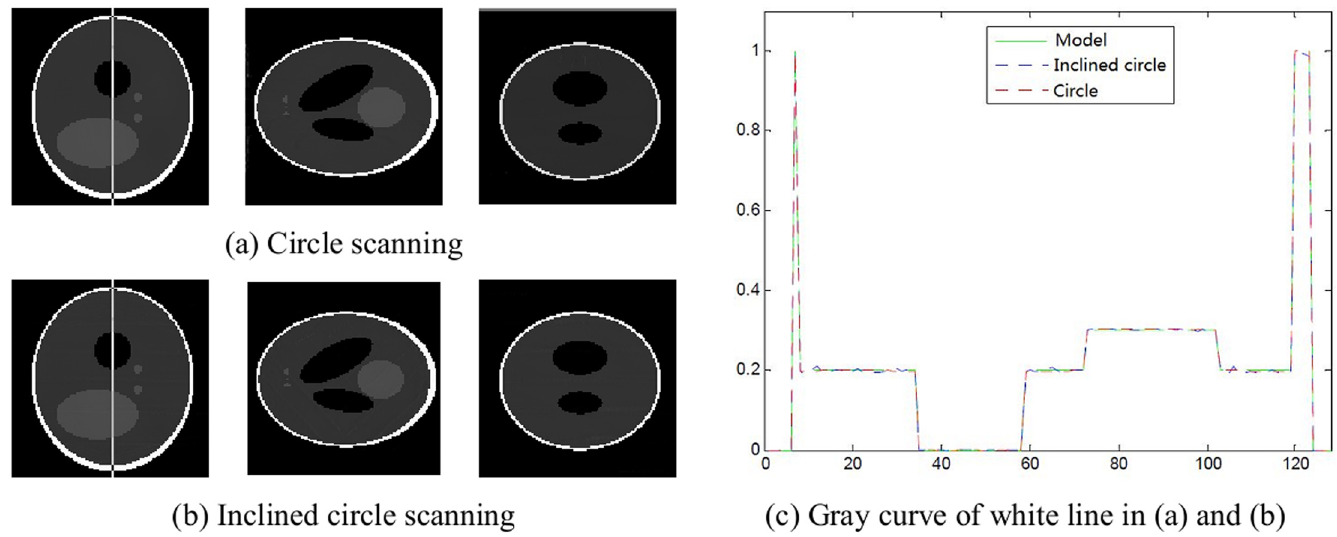
Fig 4. Slices of reconstruction image with small cone